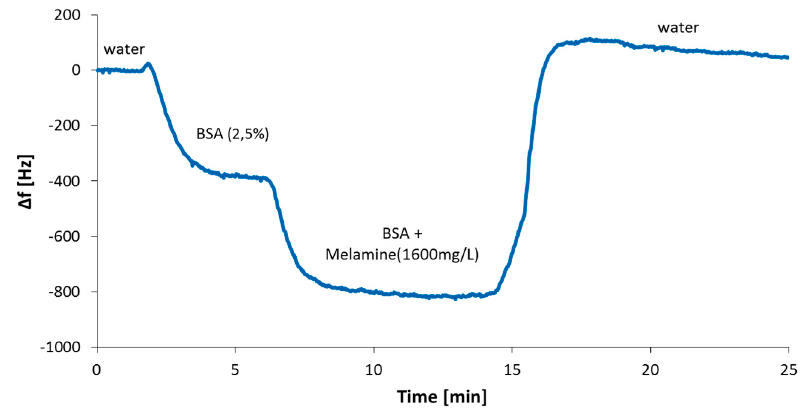
Figure 7. QCM measurement showing the reduced sensor effect upon injection of melamine (1600 mg/L) when measuring in a matrix spiked with BSA.